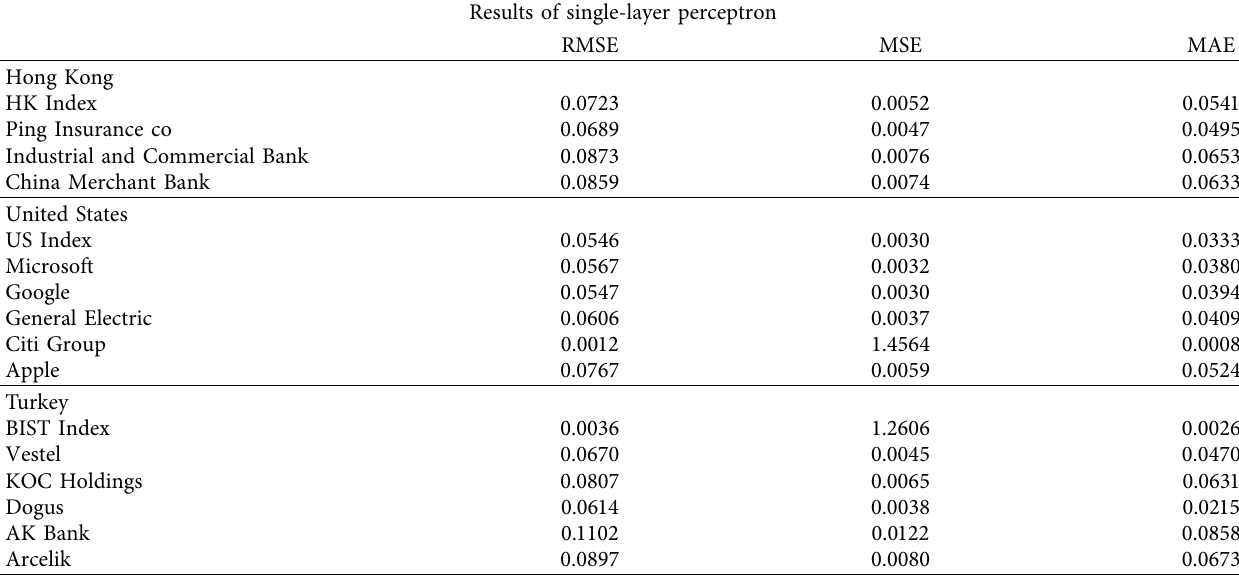
Table 14: Results of the SLP method for all companies of Hong Kong, US, and Turkey with sentiments.